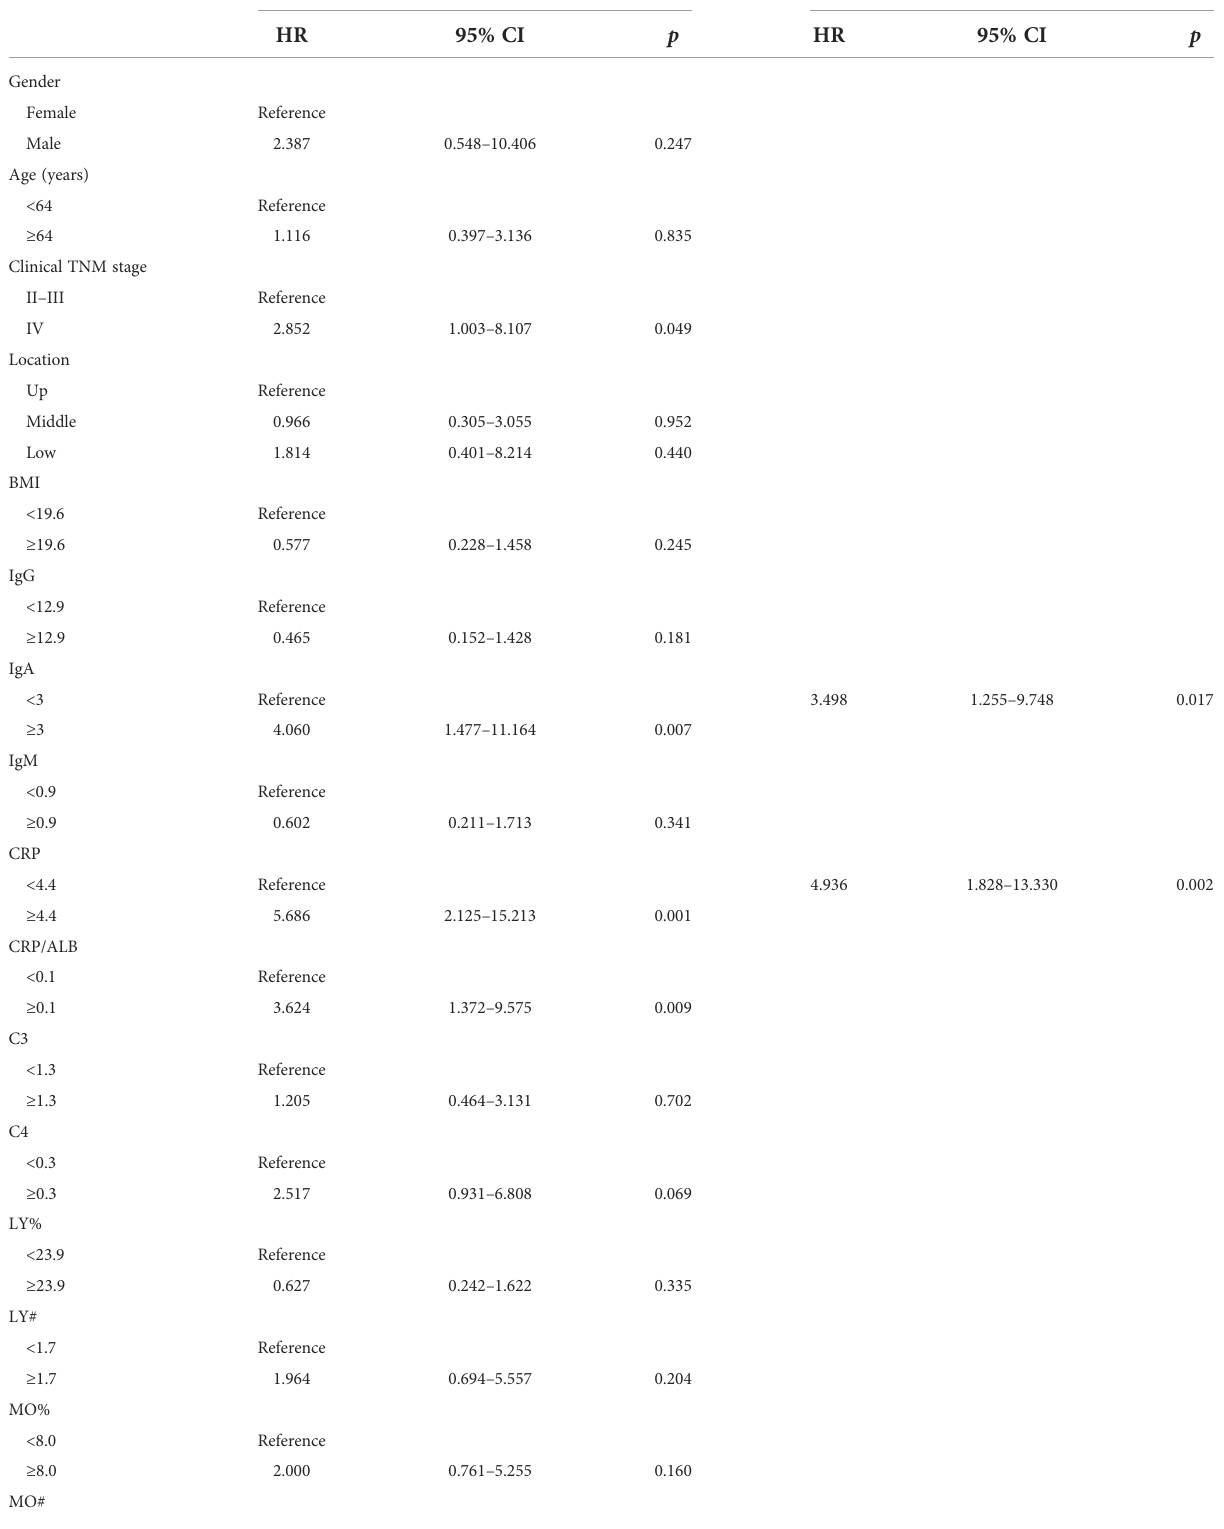
TABLE 2 Univariate and multivariate Cox analyses of training cohort for